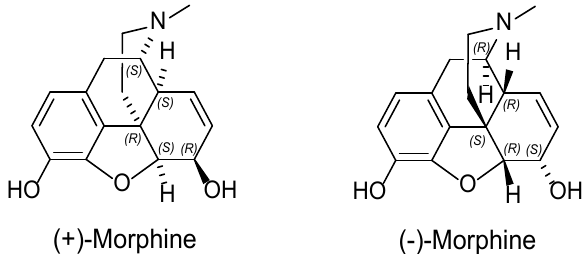
Figure 1. Structures of the bioactive (-)-Morphine and of the inac- tive (+)-Morphine.